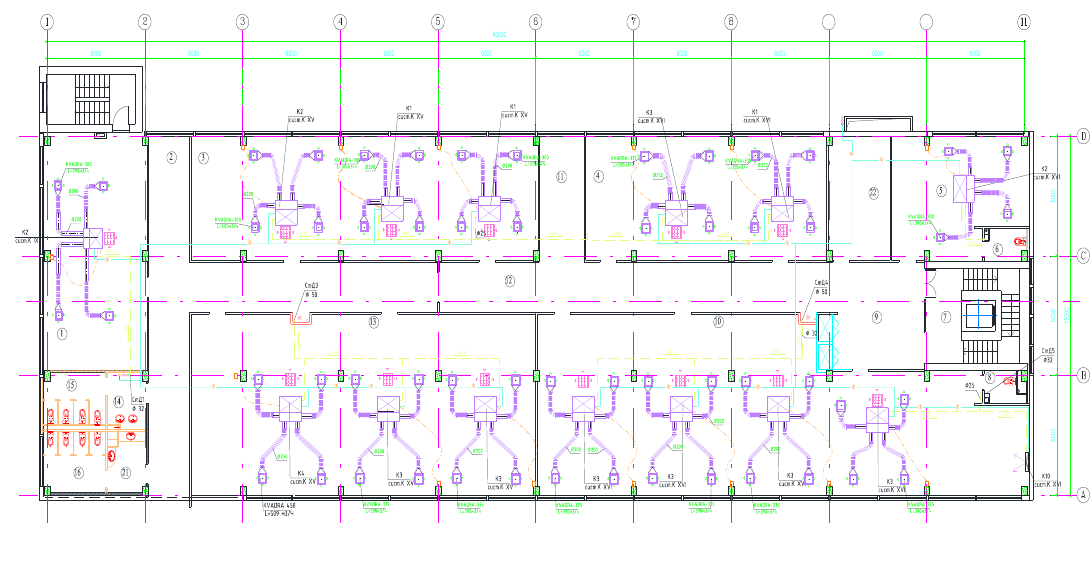
Figure 2. Plan of the office building with VRF system.